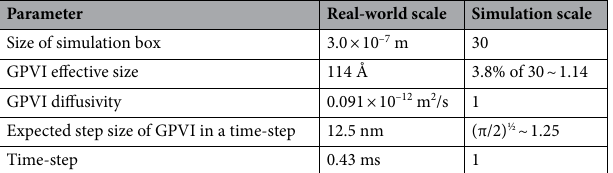
Table 1. List of real-world and simulation parameters. See estimates in “Methodology”